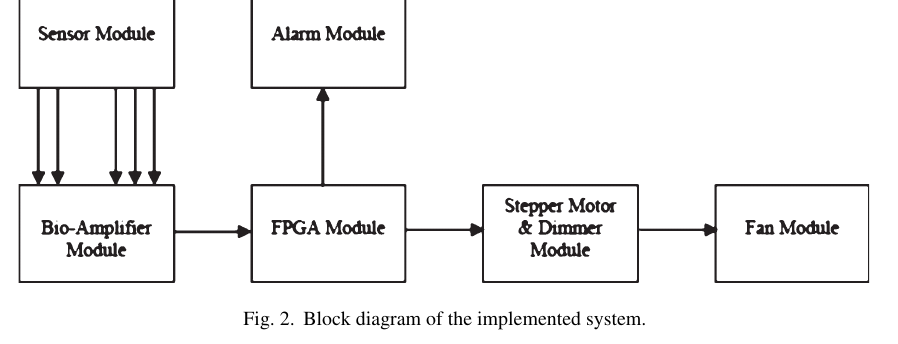
Fig. 2. Block diagram of the implemented